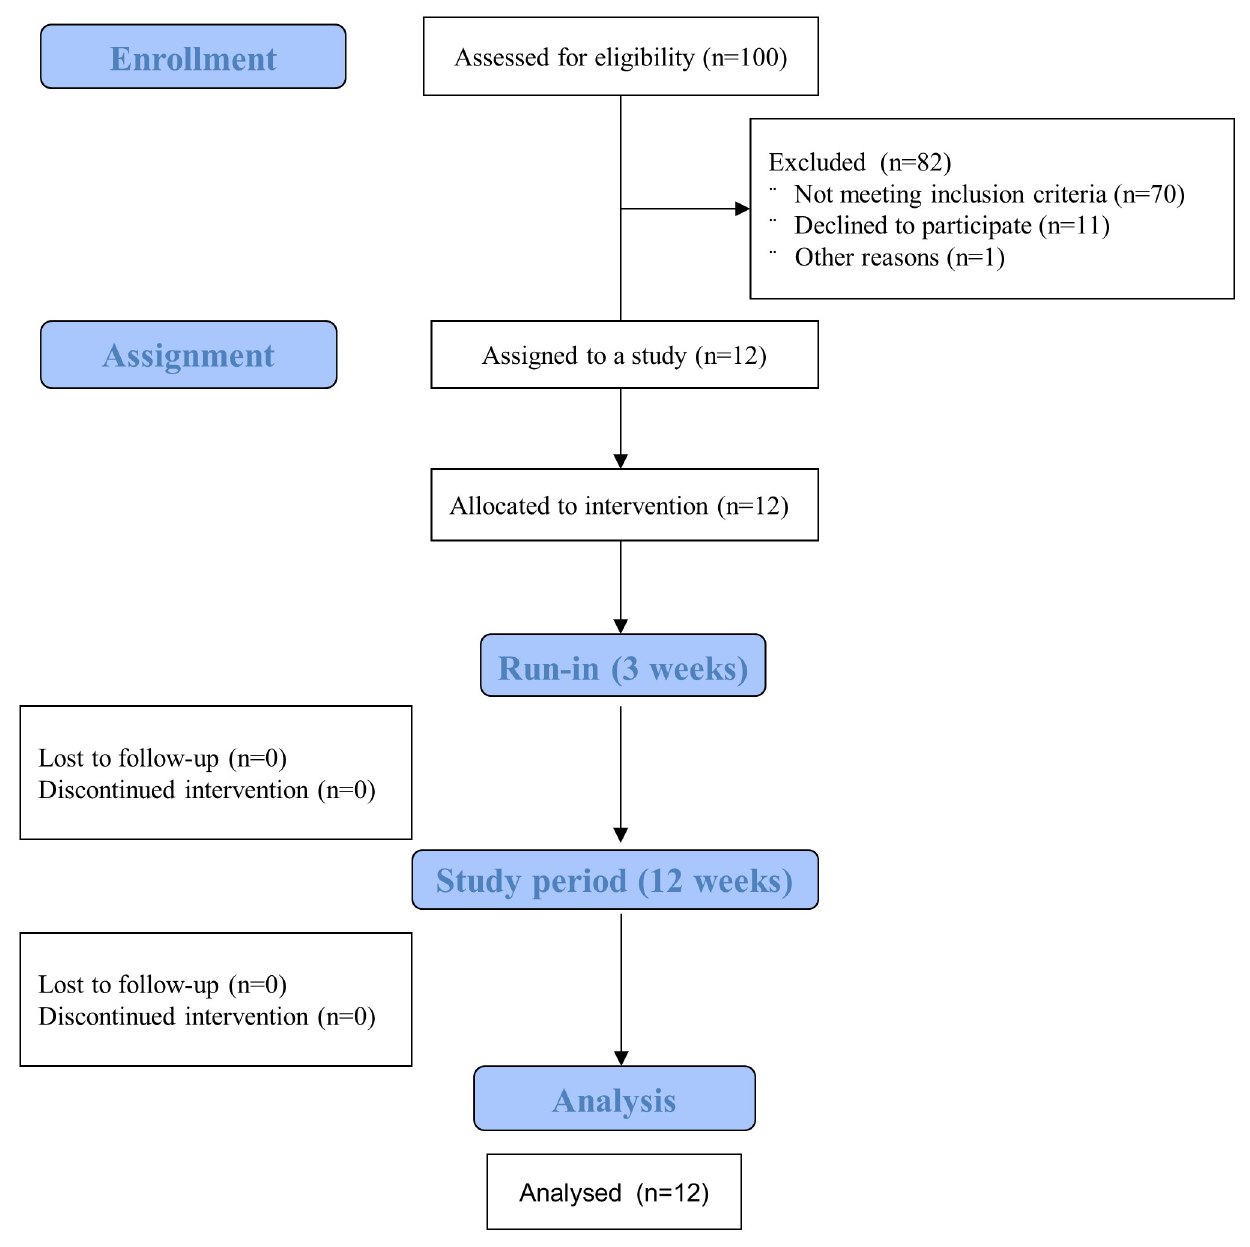
Fig 1. Flowchart of the patients’